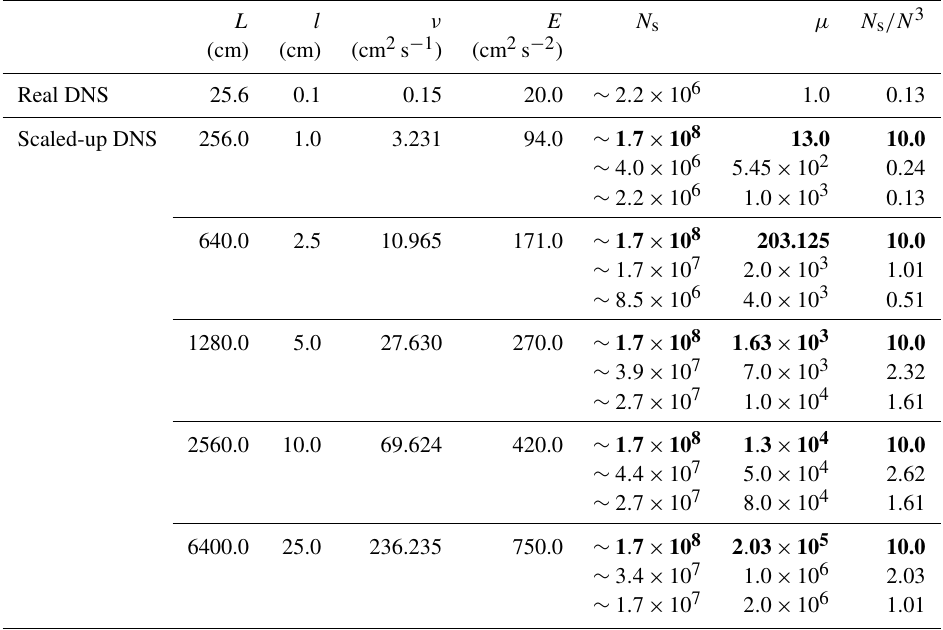
Table 2. Details of DNS and scaled-up DNS. From left to right: domain length L , grid length l , viscosity ν , turbulent kinetic energy E , number of super-droplets in the domain N s , multiplicity µ , and number of super-droplets per grid volume N s /N 3 . Numbers in bold correspond to the simulations with the highest number of super-droplets per grid volume.